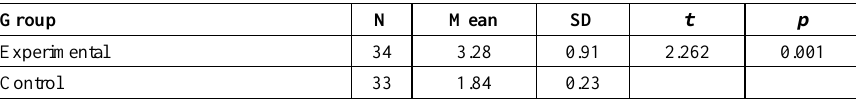
Table 9. Weekly pre-class quiz